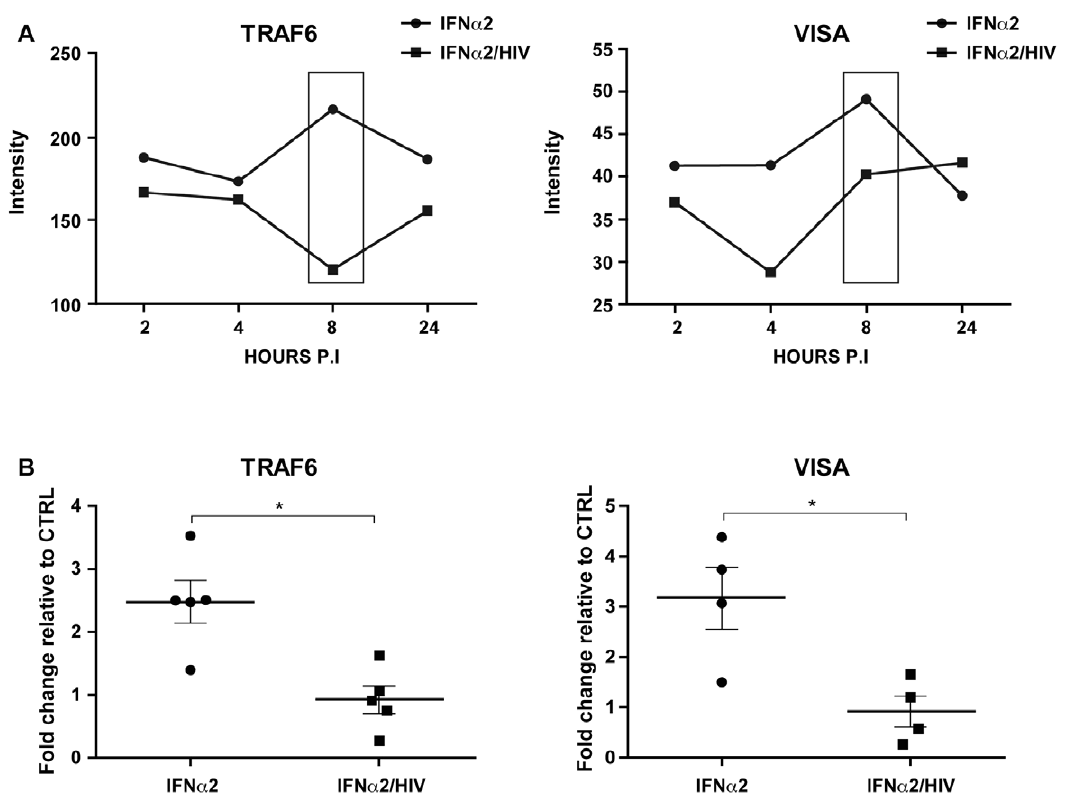
Figure 2. HIV-1 modulates TRAF6 and VISA expression in IFN a 2 pre-treated macrophages. A) Intensity of the expression of the genes of interest obtained from the oligonucleotide array analysis (U133 Plus 2.0 array) at 2, 4, 8 and 24 hours post-infection of macrophages. Cells were treated with IFN a 2 (1000 UI/ml for 18 hours) with or without HIV-1. B) Validation of the regulation of gene modulation by HIV-1 in IFN a 2 pre-treated macrophages (differentiated with human serum) at 8 hours post-infection. Non-IFN a 2 treated and non-HIV infected macrophages were used as negative control. An * denotes a significant difference (P , 01, paired t -test) between IFN a 2 pre-treated or not macrophages. The expression level was calculated by qRT-PCR assessments obtained from four donors and normalized to the level of